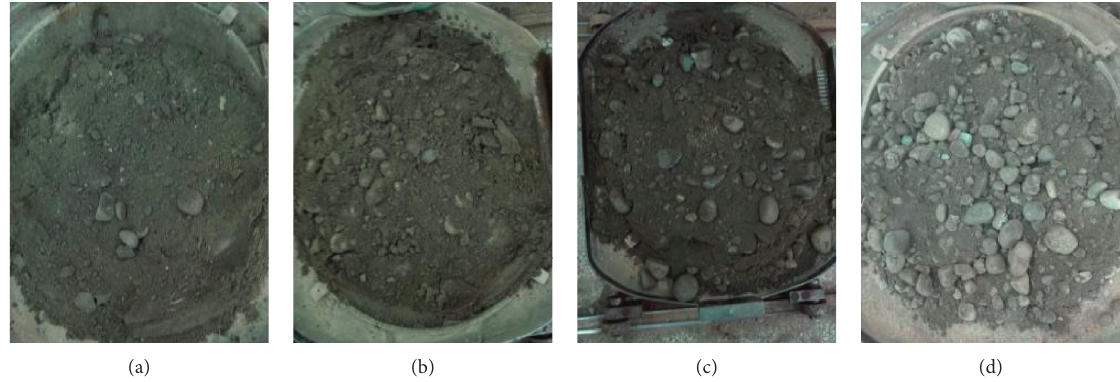
Figure 1: Samples of sand and cobble soil. (a) CC � 20%. (b) CC � 40%. (c) CC � 60%. (d) CC � 80%.